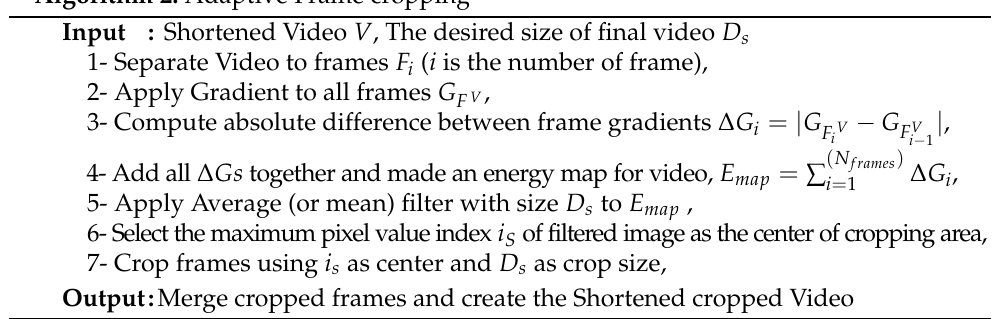
Algorithm 2: Adaptive Frame